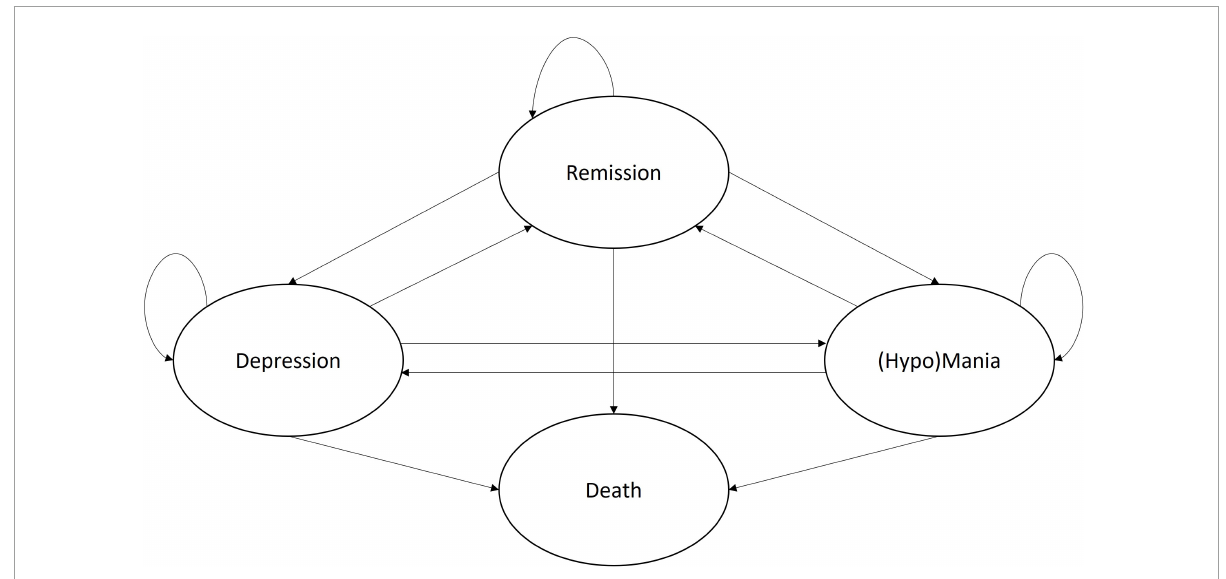
FIGURE1 Final conceptual Markov model for the treatment of Bipolar Disorder. Adapted version of the model published by Ekman et al. (33).